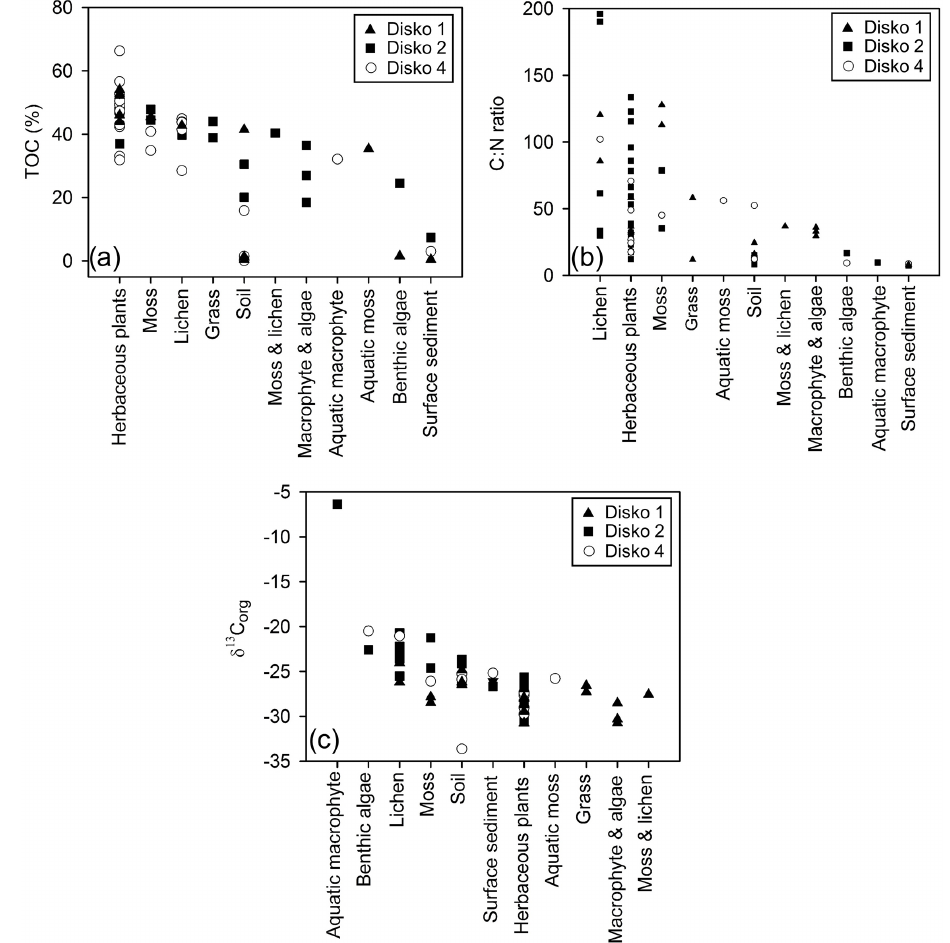
Figure 3. (a) TOC (%), (b) C org : N ratio and (c) δ 13 C org plotted against sample type, separated by lake catchment.